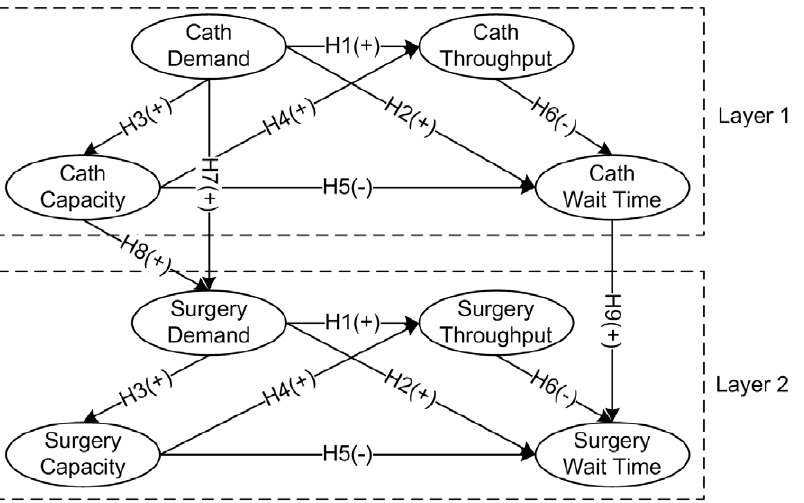
Figure 3. An illustration of a two-layer wait time model. (Cath: the abbreviation of catheterization; Surgery: the shorter form of cardiac surgery; H1-H9: the research hypotheses; + / 2 : a positive or a negative relationship between the variables towards the arrow.)